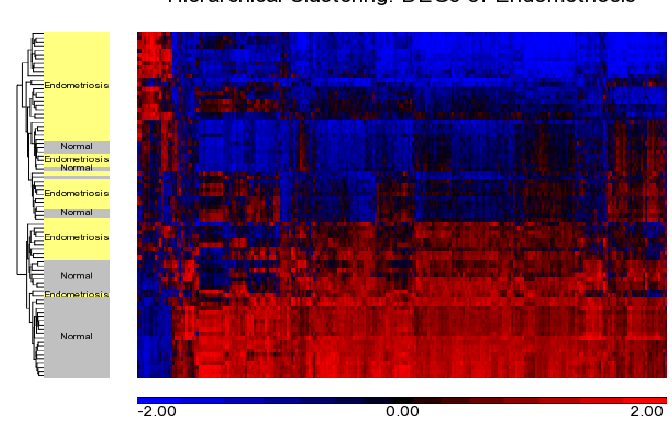
Figure 1. PCA showing two clear distinct clusters for severe endometriosis cases and normal healthy controls without uterine pathology.